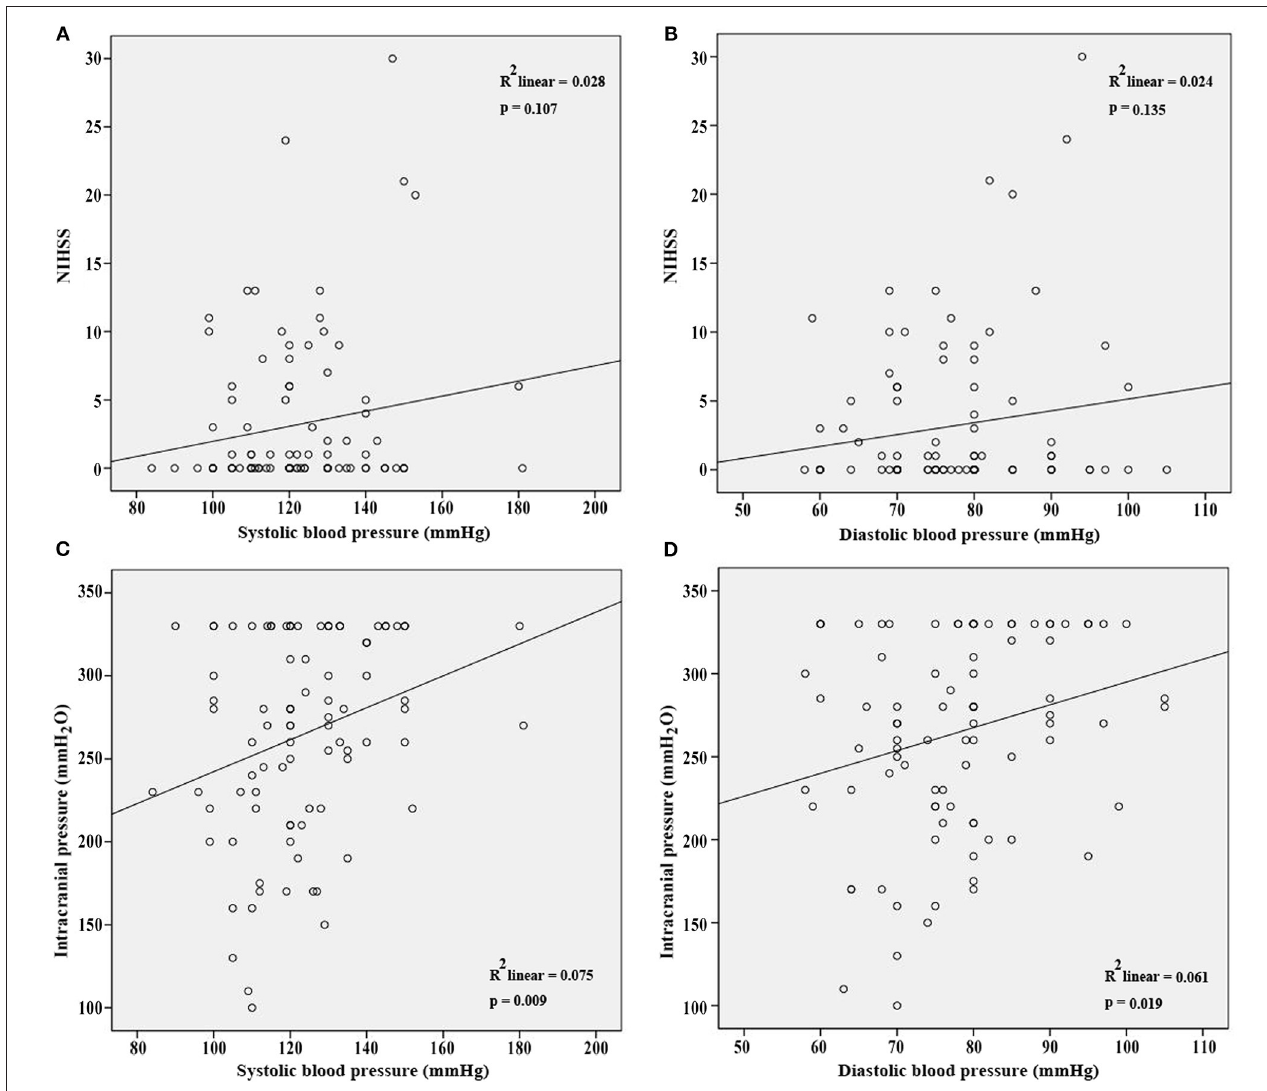
FIGURE 1 | SBP and DBP were not correlated with NIHSS (A,B) at admission. However, SBP and DBP were positively correlated with ICP at admission (C,D) .